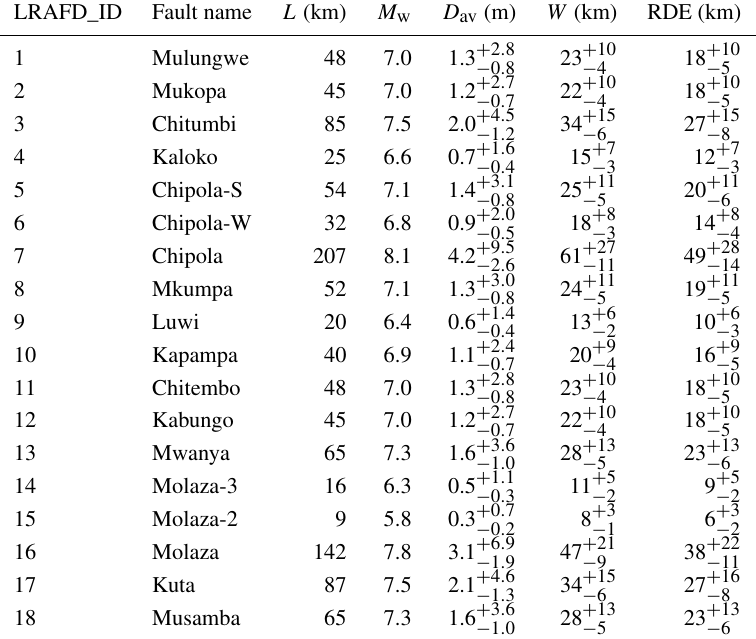
Table 3. Seismogenic source properties for faults in the LRAFD, calculated using the fault scaling laws set out in Leonard (2010); https: //doi.org/10.5281/zenodo.6513778 (Turner et al., 2022b). The length ( L ) of each fault is measured in a straight line between the two tips, estimated earthquake magnitude ( M w ) from applying Eq. (1), displacement ( D av ,m) using Eq. (2), width ( W ) calculated using Eq. (3), and rupture depth extent (RDE) using Eq. (4) and the intermediate dip value of 53 ◦ . The uncertainties for each parameter are calculated by propagating the empirical uncertainties from Leonard